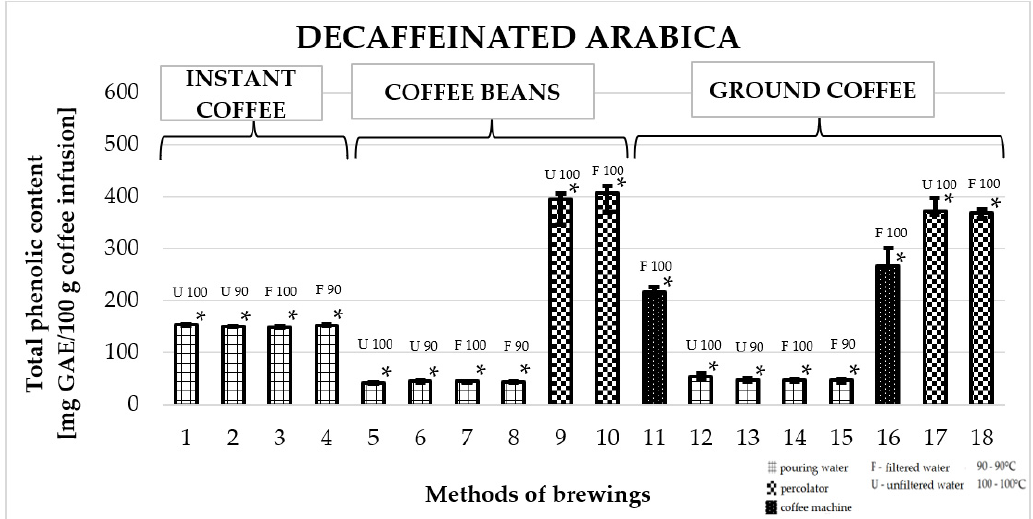
Figure 3. Median of total phenolic content as gallic acid equivalent [mg GAE / 100 g of infusion] in 100% deca ff einated Arabica co ff ee. * p 1 / 3,5,6,7,8,9,10,11,12,13,14,15,16,17,18 ; * p 2 / 5,6,7,8,9,10,11,12,13,14,15,16,17,18 ; * p 3 /